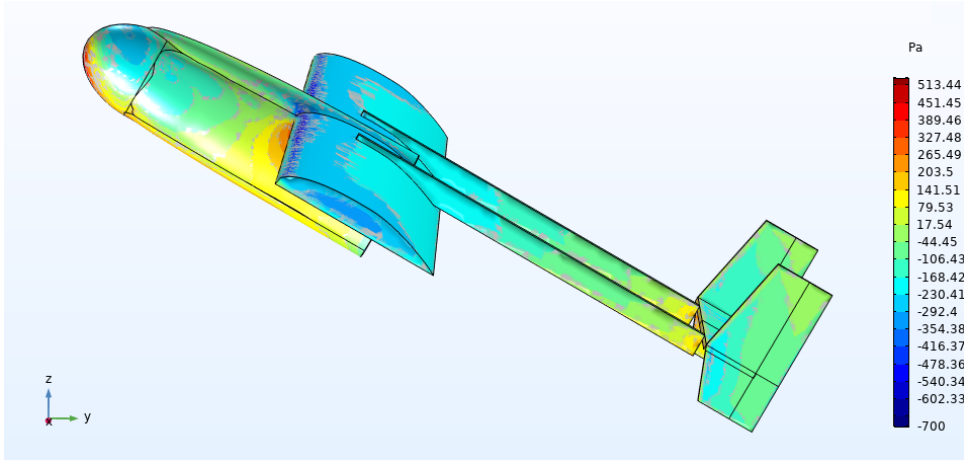
Figure 4. Lateral and top UAV focused view of maximum pressure in Pa at 2000m of altitude and 30°